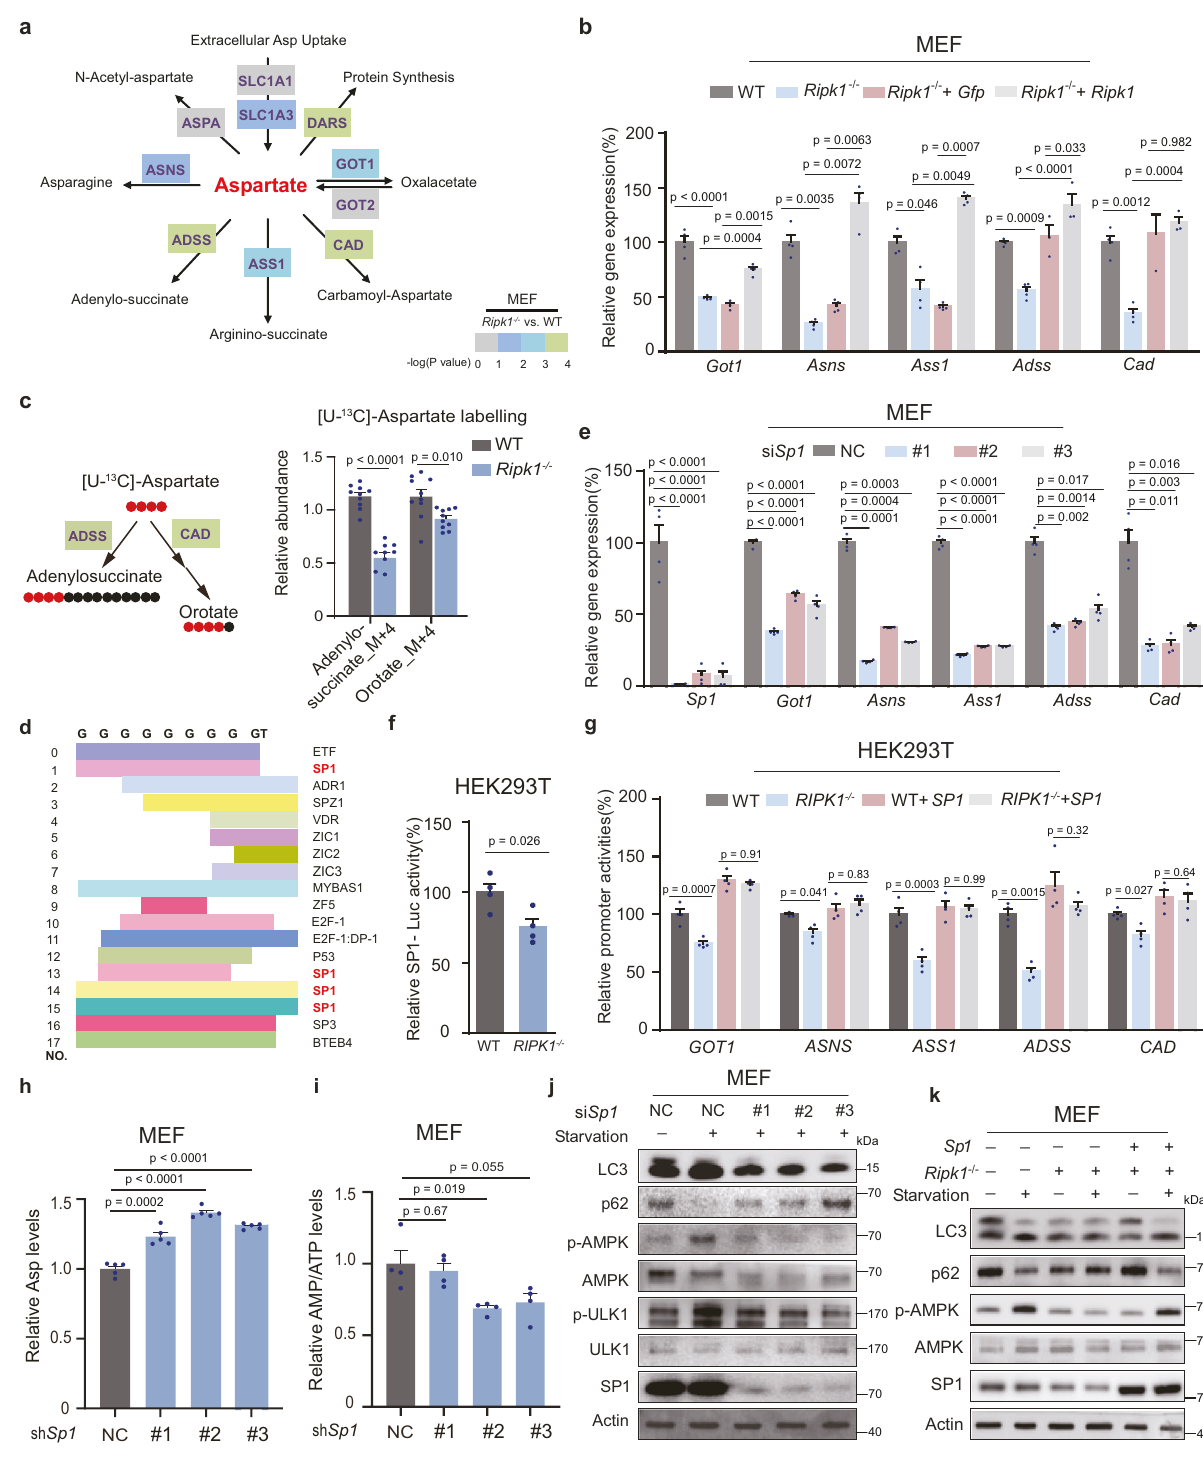
Electron microscopy . Mice were perfused fi rst with PBS and then 4% paraf- ormaldehyde (PFA) and 1% glutaraldehyde for 4 h at 25 °C, and then post fi xed in This structure is distinctly visible by TEM as two parallel membrane